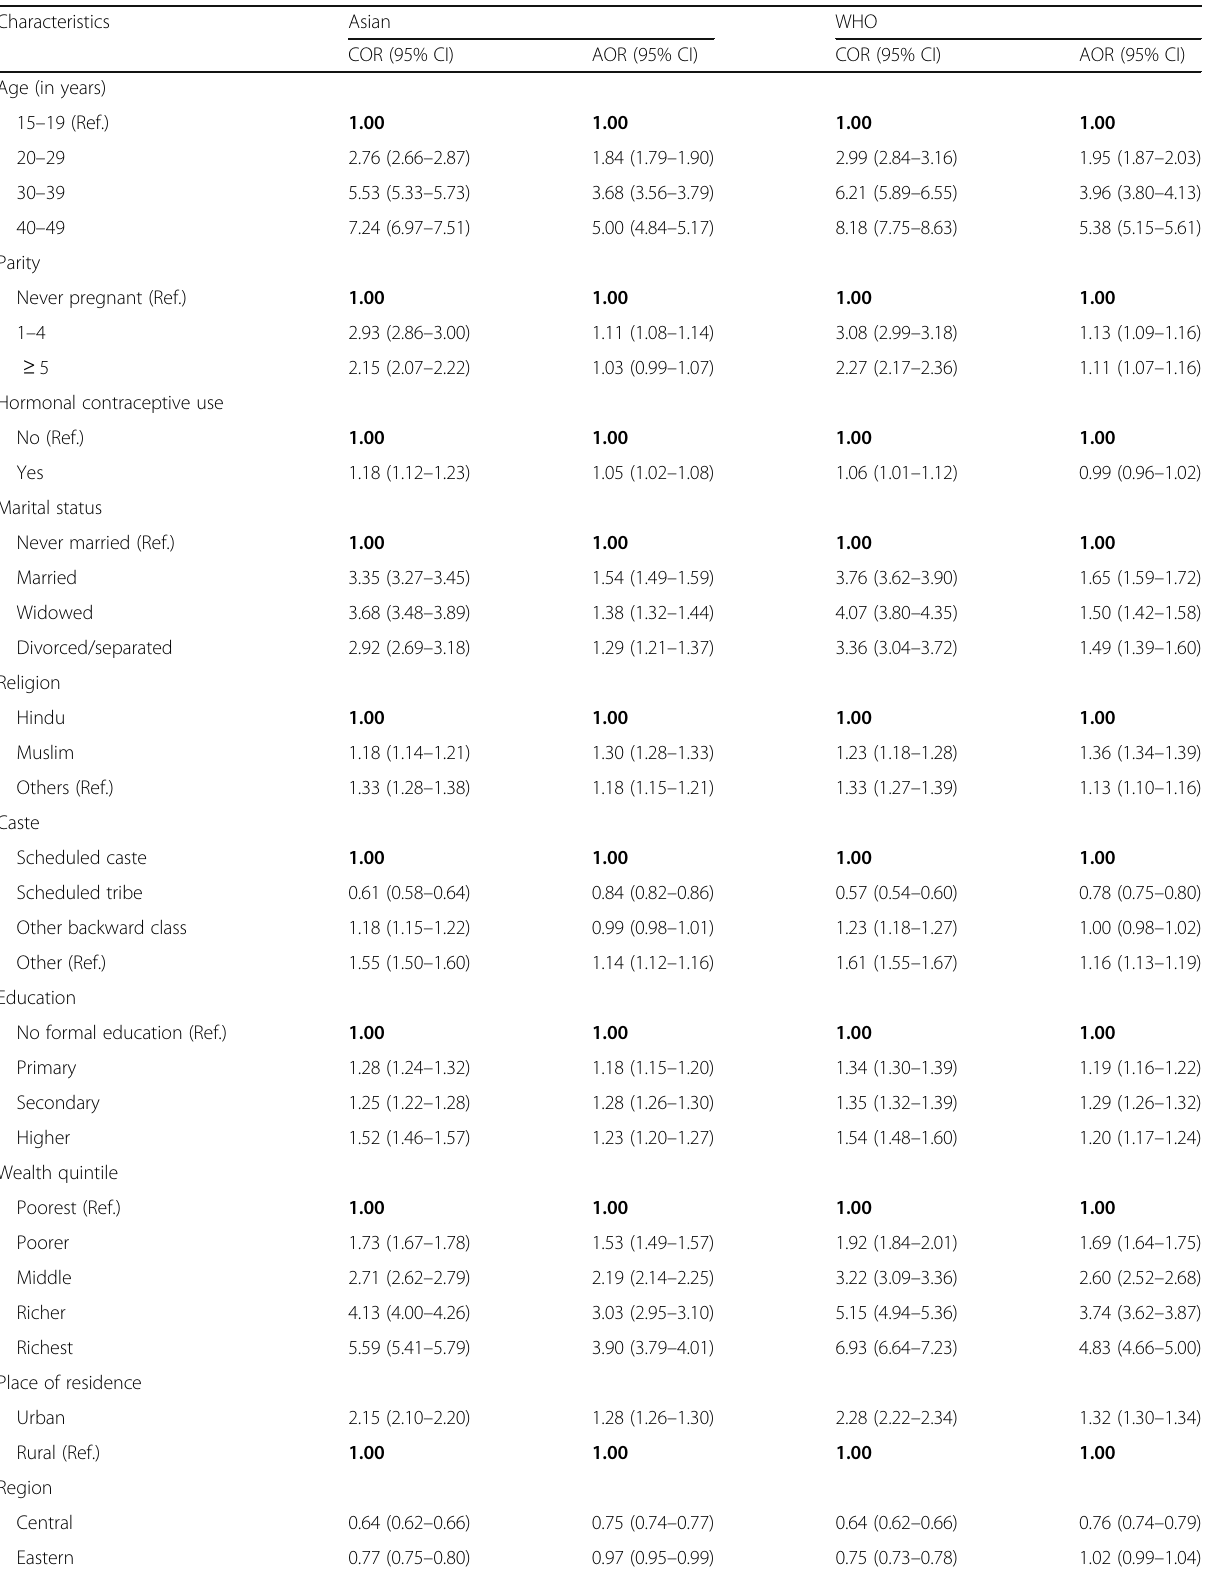
Table 4 Determinants of overweight/obesity among women of reproductive age in India 1,2